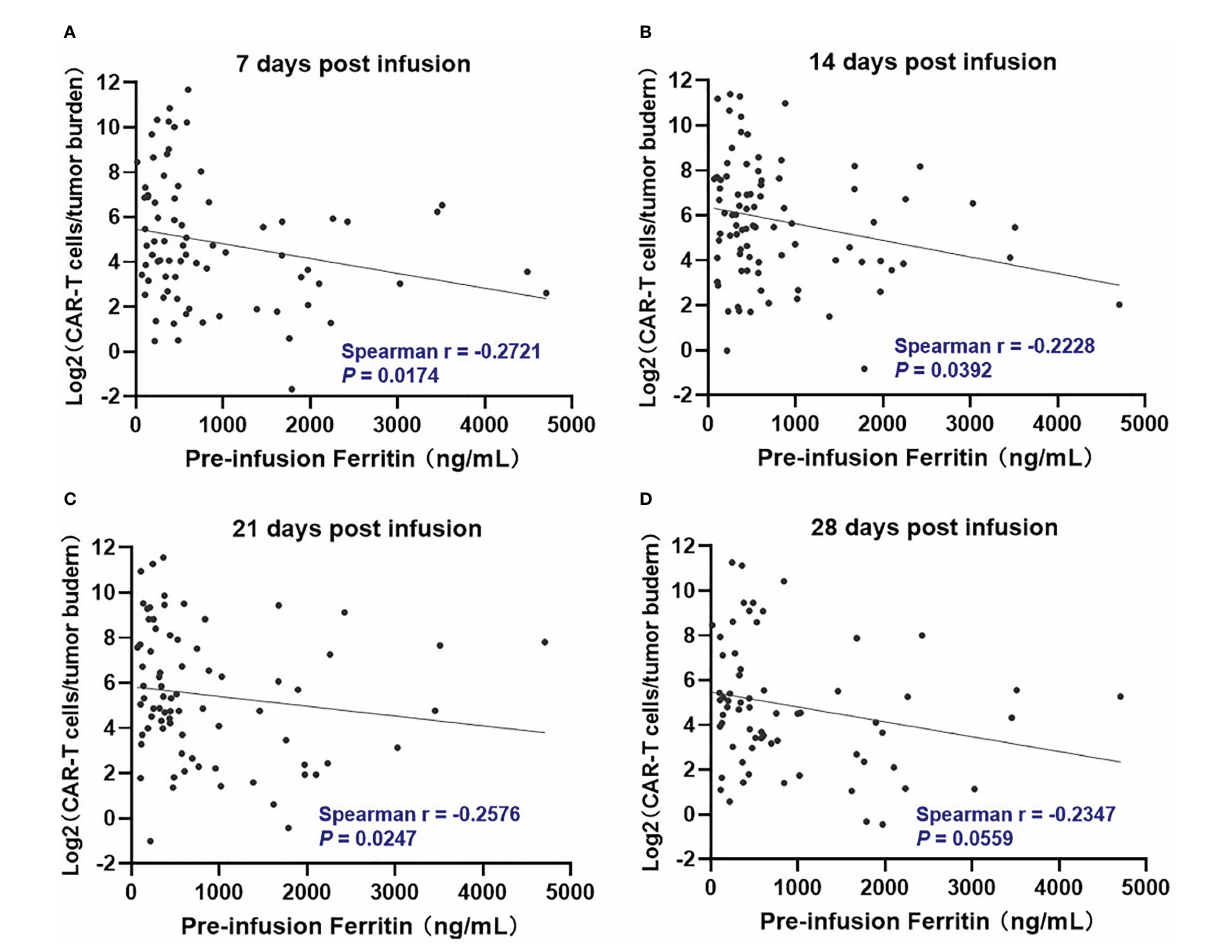
FIGURE 1 Correlation between pre-infusion ferritin and in vivo CAR T-cell expansion normalized to tumor burden during the fi rst month following CAR-T cell infusion. At day 7, 14, and 21 post infusion (A – C) , CAR-T cell expansion normalized to baseline tumor burden was negatively correlated with ferritin, and the correlation did not remain at day 28 (D) . Tumor burden was de fi ned as percentage of plasma cells in bone marrow. Spearman r value was calculated using the Spearman's correlation